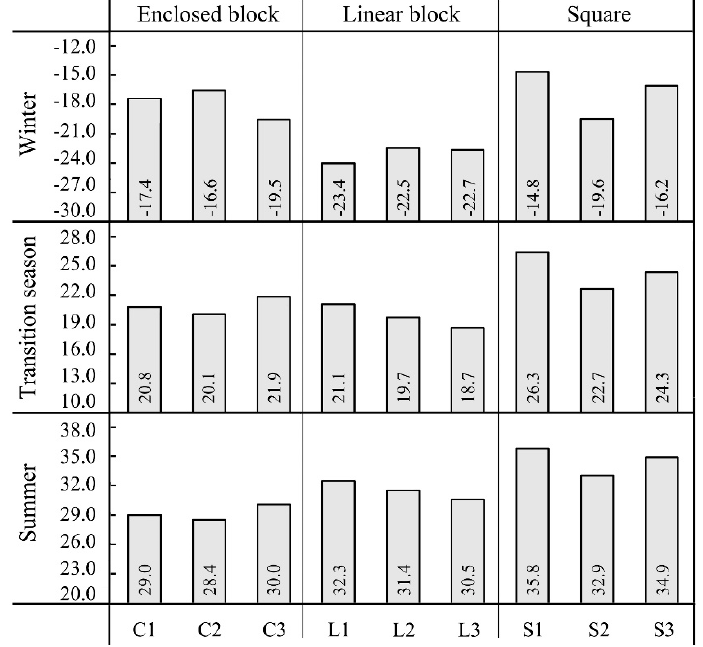
◦ C) of each measurement point in di ff erent Figure 12. Average PET ( ℃ ) of each measurement point in different seasons. Figure 12. Average PET (